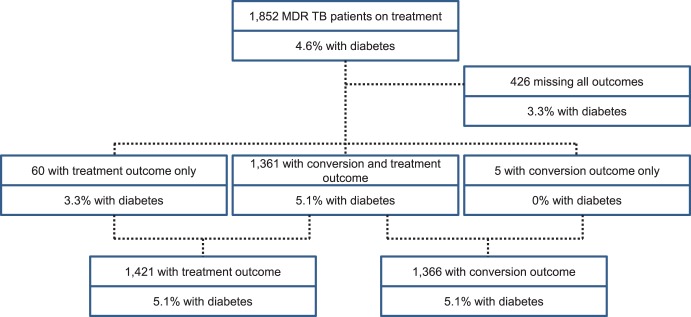
Study flow diagram of patients with MDR TB in Georgia, 2009–2011.